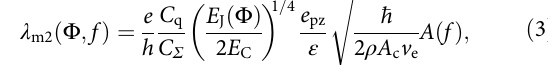
lines in order to easily populate and measure the SAW cavity modes, while port 3 is highly attenuated ( ≈ 70 dB) such that the CPWR and qubit are close to their quantum-mechanical ground states.